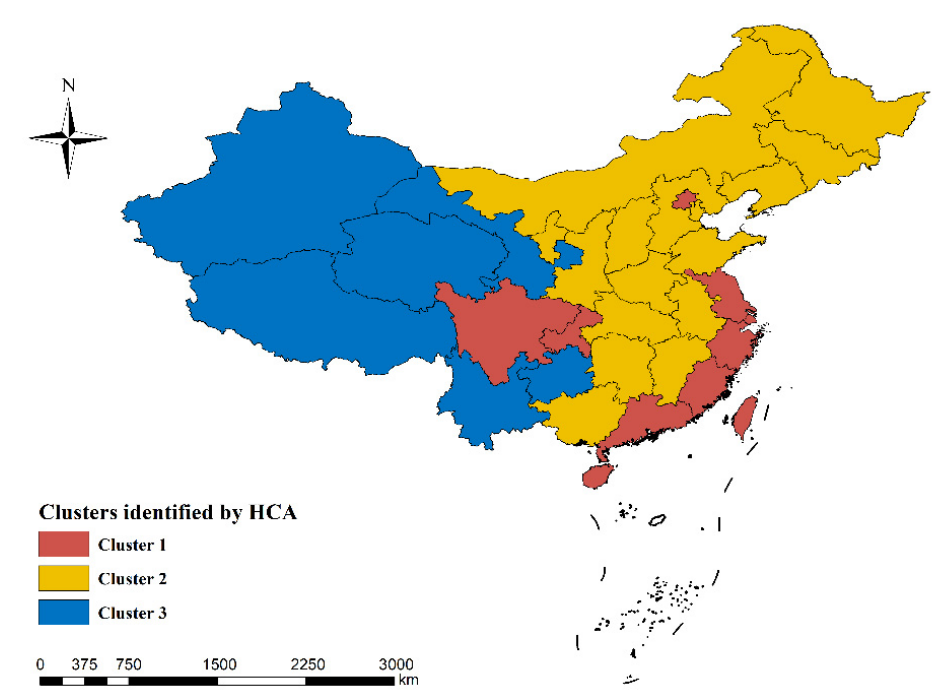
Figure 3. Distribution of the clusters identified by hierarchical cluster analysis (HCA). Table 3. Comparison of oxygen concentration and age-standardized years of life lost per 100,000 population for several causes of death between the clusters λ .